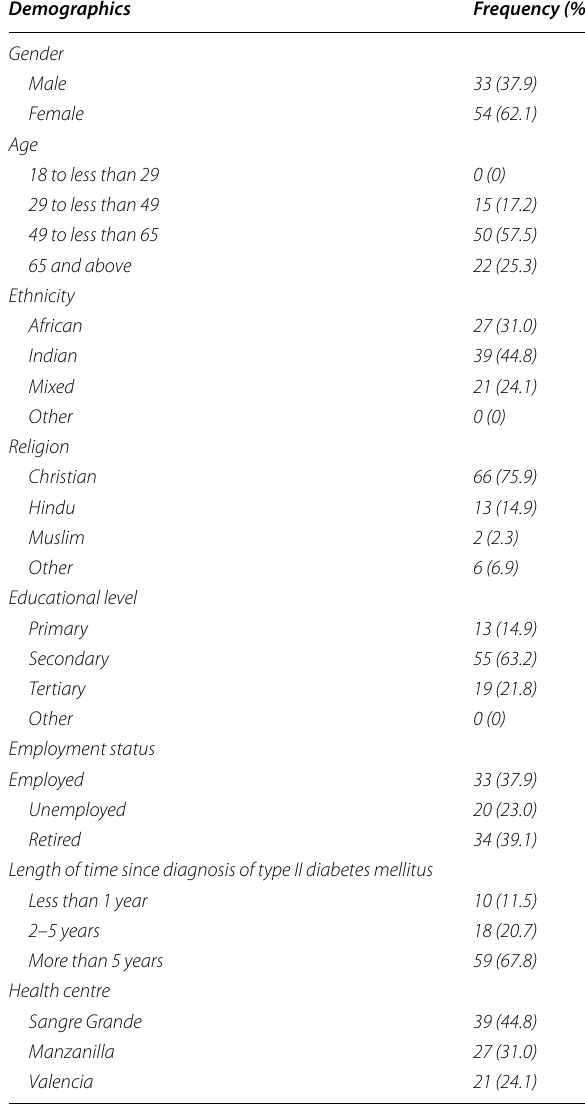
Table 2 Sociodemographic characteristics of persons with type II diabetes mellitus attending selected health centres in East Trinidad ( n =